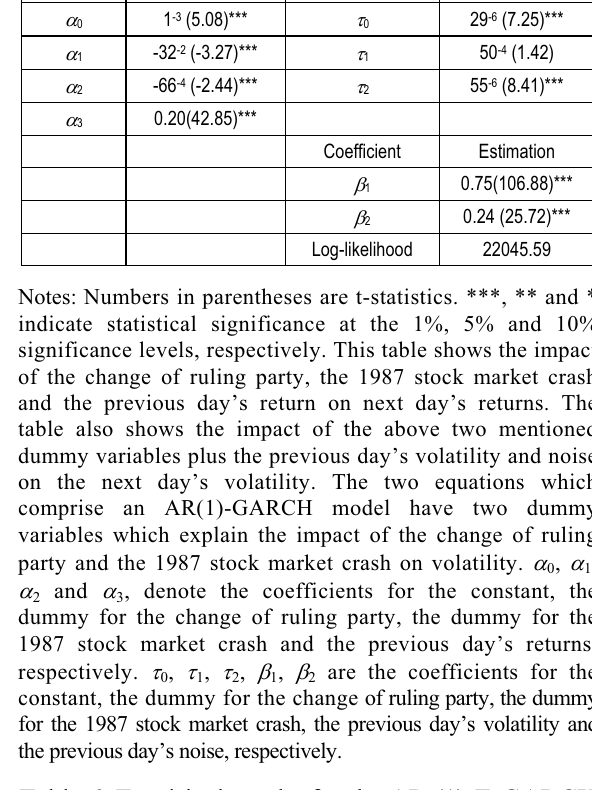
Table 6. Empirical results for the AR (1)-E-GARCH (1,1)